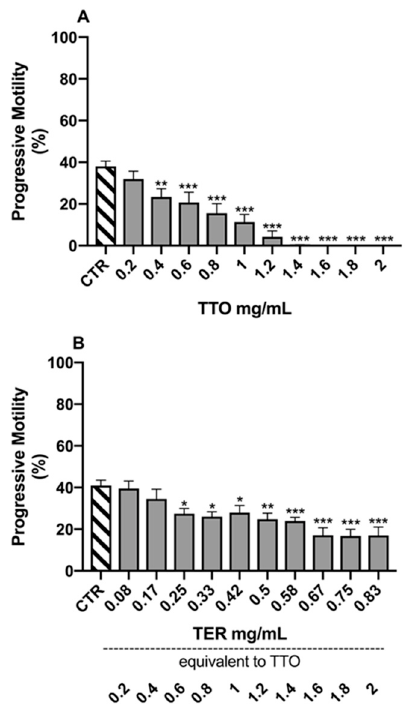
Figure 3. Effects of tea tree oil ( A ) and terpinen-4-ol ( B ) on total sperm motility. Data are expressed as mean ± standard error of the mean. CTR = control samples (only emulsifiers). * = p < 0.05; *** = p < 0.001.